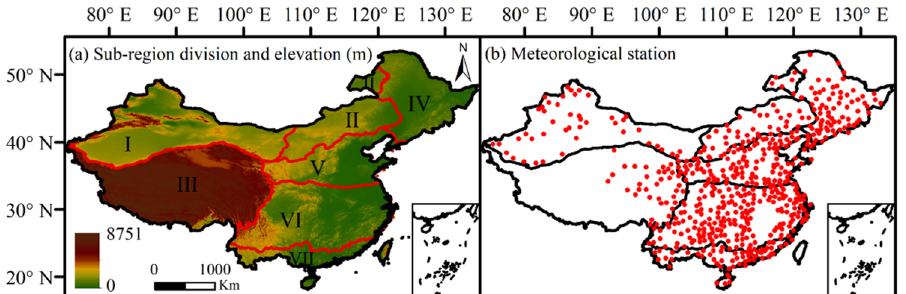
Figure 1. The digital evaluation of the sub-region divisions and the distribution of the weather sta- tions. ( a ) Sub-region division and elevation; ( b ) Meteorological station. stations. ( a ) Sub-region division and elevation; ( b ) Meteorological